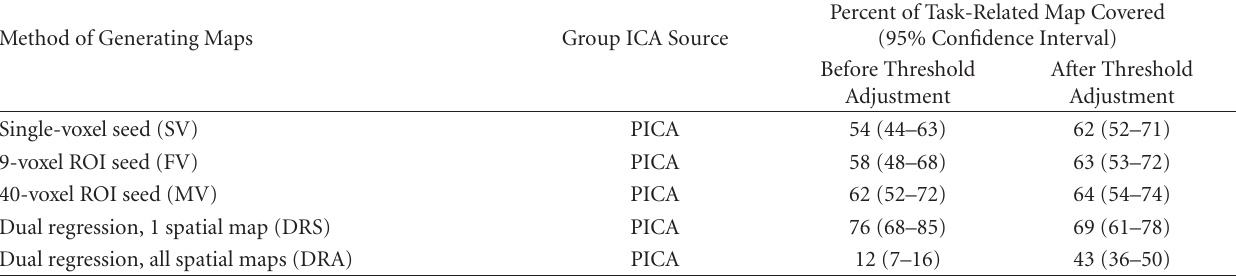
Table 8: Experiment 5: mean percentages of thresholded task-related GLM maps that are covered by the thresholded subject-specific FC maps generated with each hybrid method below. The right-most column gives percentages after adjusting the z-score used to threshold the FC maps so that number of false positives equals number of false negatives. The results are similar to those from Experiment 3, with DRA covering less of the task-related maps than the SV, FV, MV, and DRS